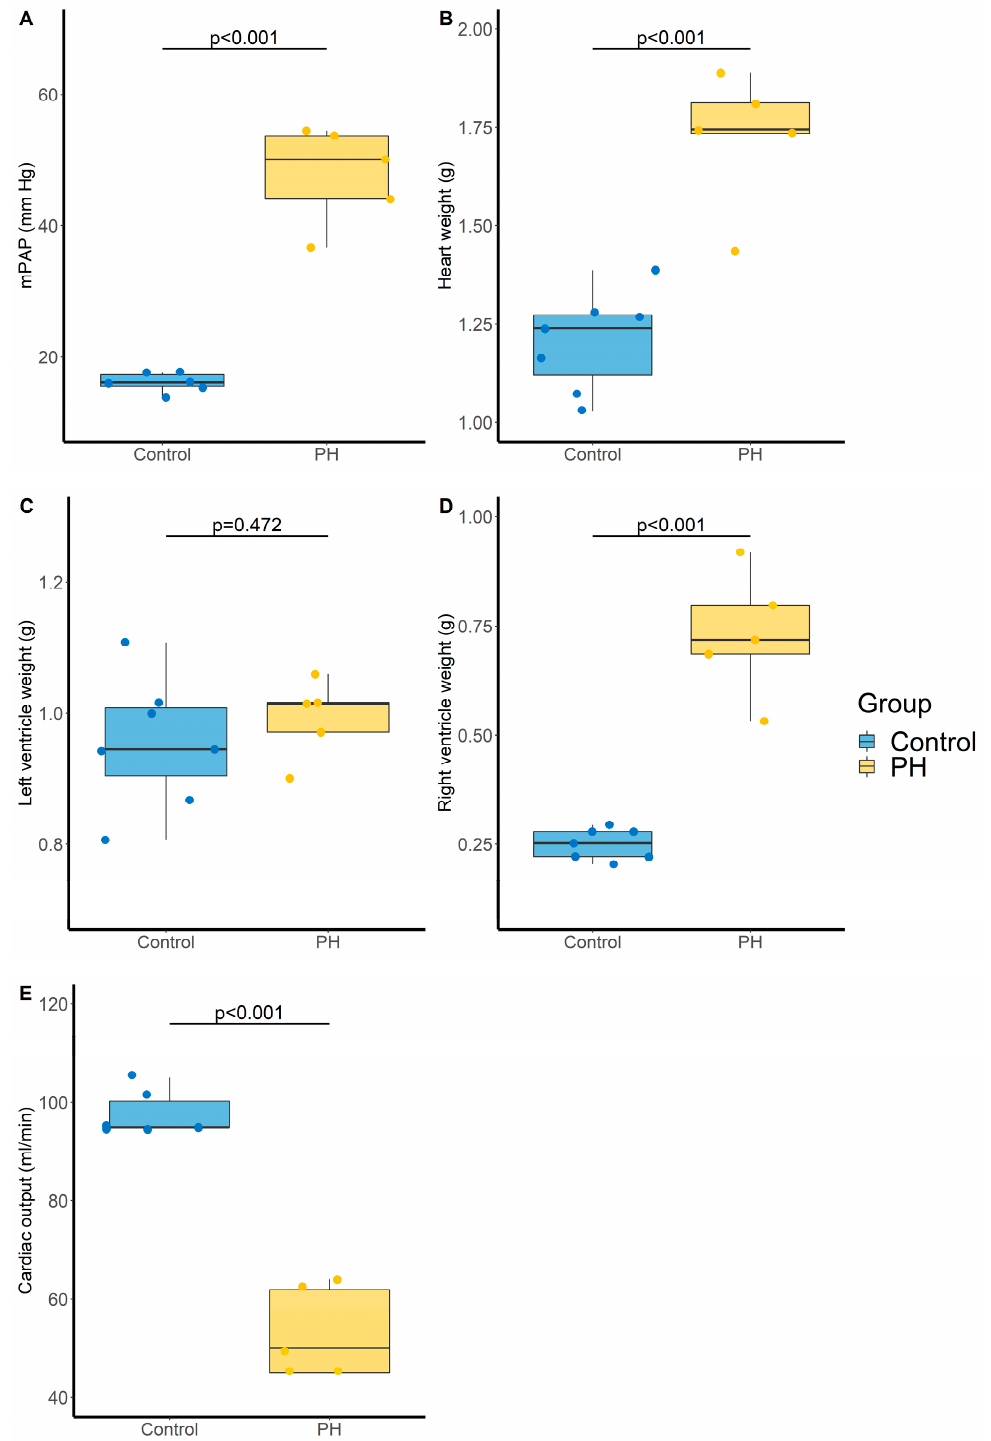
Figure 4. Evaluation of pulmonary and cardiac parameters in control and PH rats. ( A ) Mean pulmonary arterial pressure (mPAP, mm Hg). N = 6 and 5 for Control and PH, respectively, ( B ) Heart weight (g). N = 7 and 5 for Control and PH, respectively, ( C ) Left ventricle weight (g). N = 7 and 5 for Control and PH, respectively, ( D ) Right ventricle weight (g). N = 7 and 5 for Control and PH, respectively, and ( E ) cardiac output (mL/min). N = 6 and 5 for Control and PH, respectively. PH: pulmonary hypertension. p -values computed by Student’s t -test.